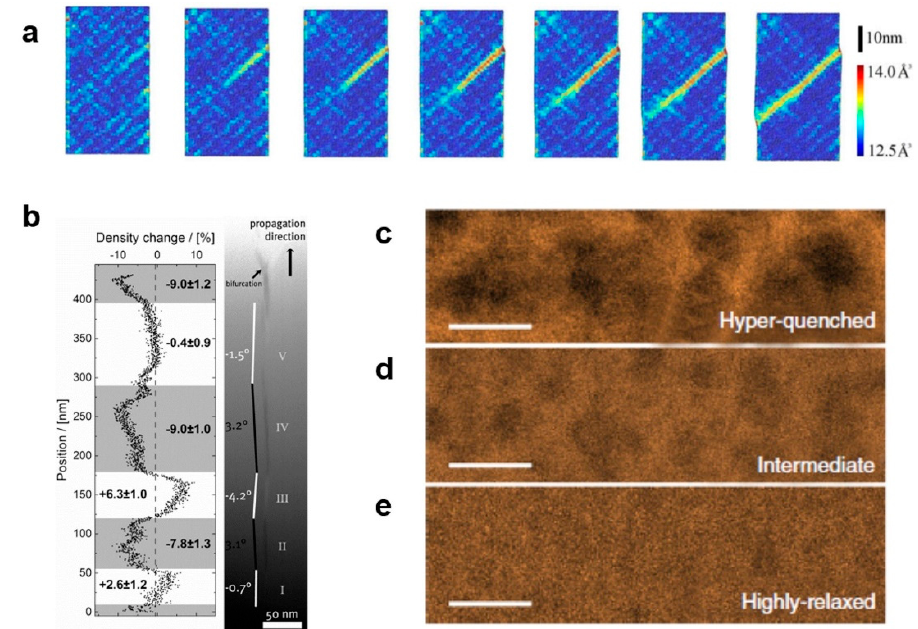
Figure 1. ( a ) Distribution of the Voronoi volume in a sample during straining from 7–7.24% with a strain interval of 0.04%. Reproduced from [34], with permission of Elsevier, 2009. ( b ) Density variations in a shear band. Reproduced from [37], with permission of APS, 2017. ( c – e ) High-angle annular dark-field scanning TEM (HAADF-STEM) images of c the hyper-quenched, d the intermediate and e the highly relaxed samples. Scale bar, 5 nm. Reproduced from [38], with permission of Nature communications, 2018.